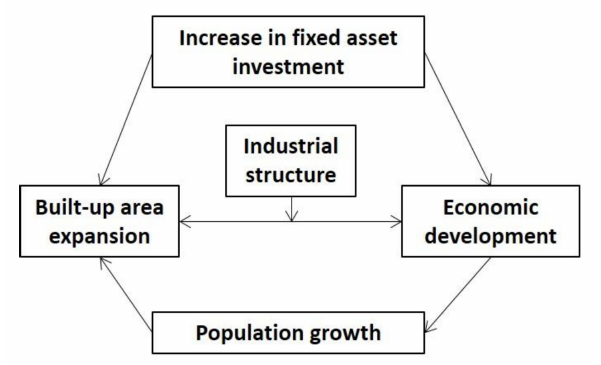
Figure 4. The conceptual framework of built-up area expansion in